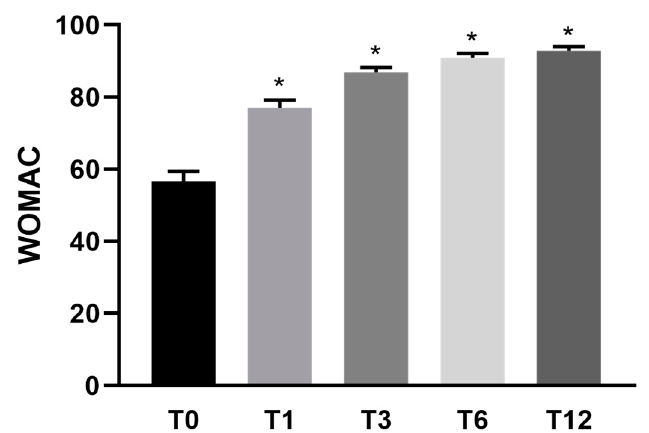
Figure 2. Mean WOMAC functional score ( n = 30) before and after Lipocell treatment. T0 is pre- treatment, Tx is x months after the treatment. Error bars show SEM * p vs. pre-treatment <0.01.